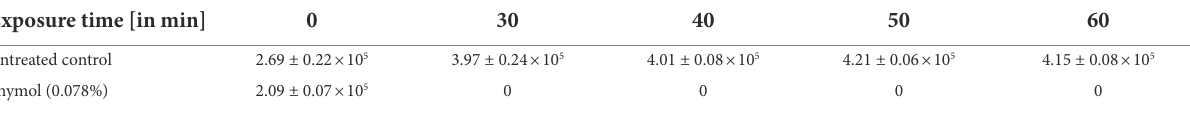
TABLE 7 Number of living bacterial cells in 1 h period from the exposition of Xanthomonas campestris pv. campestris NCPPB 528 T to the 0.078% thymol solution [CFU mL − 1 ]. Exposure time [in